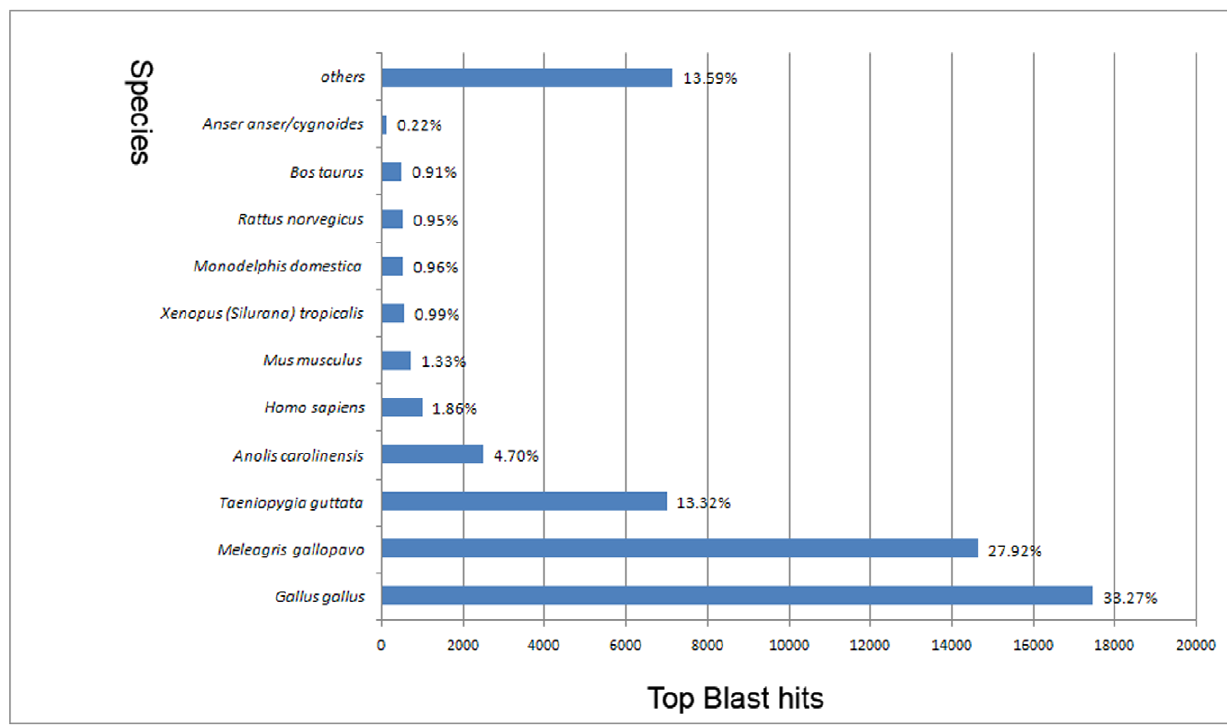
Figure 2. Top-Hit species distribution. 52,642 BLASTX-hit transcripts were calculated. More than 30% of the identified transcripts have the highest homology with Gallus gallus . Less than 0.3% of the top hits matched goose.